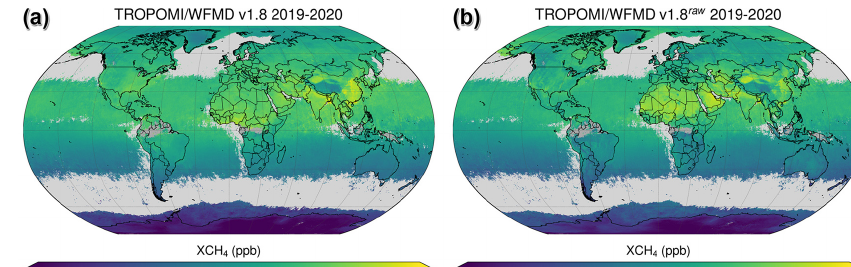
Figure 12. Global XCH 4 data (a) after and (b) before calibration. Panel (c) shows the calibration (cid:49) (defined via XCH 4 = XCH raw after correcting for the global mean difference of